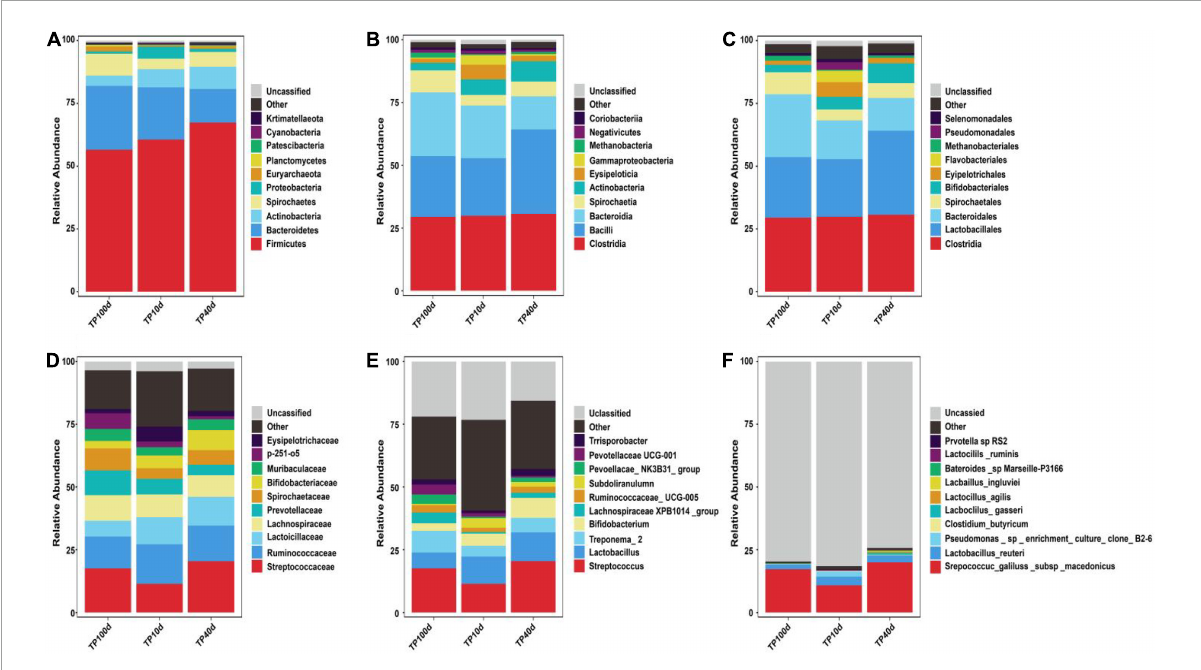
FIGURE2 Relative abundance (Top10) of intestinal microflora in Tibetan pigs. At boundary (A) , phylum (B) , class (C) , order (D) , family (E) , and genus (F) levels at different growth